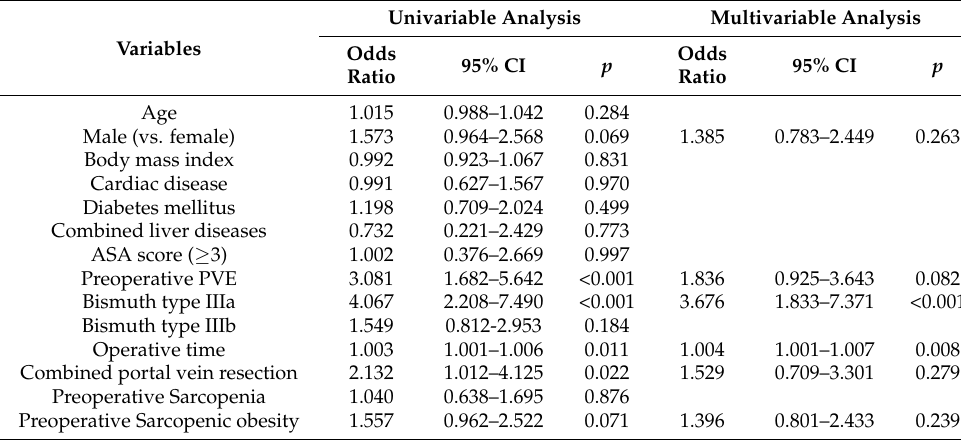
Table 4. Risk factor analysis for grade B or C post-hepatectomy liver